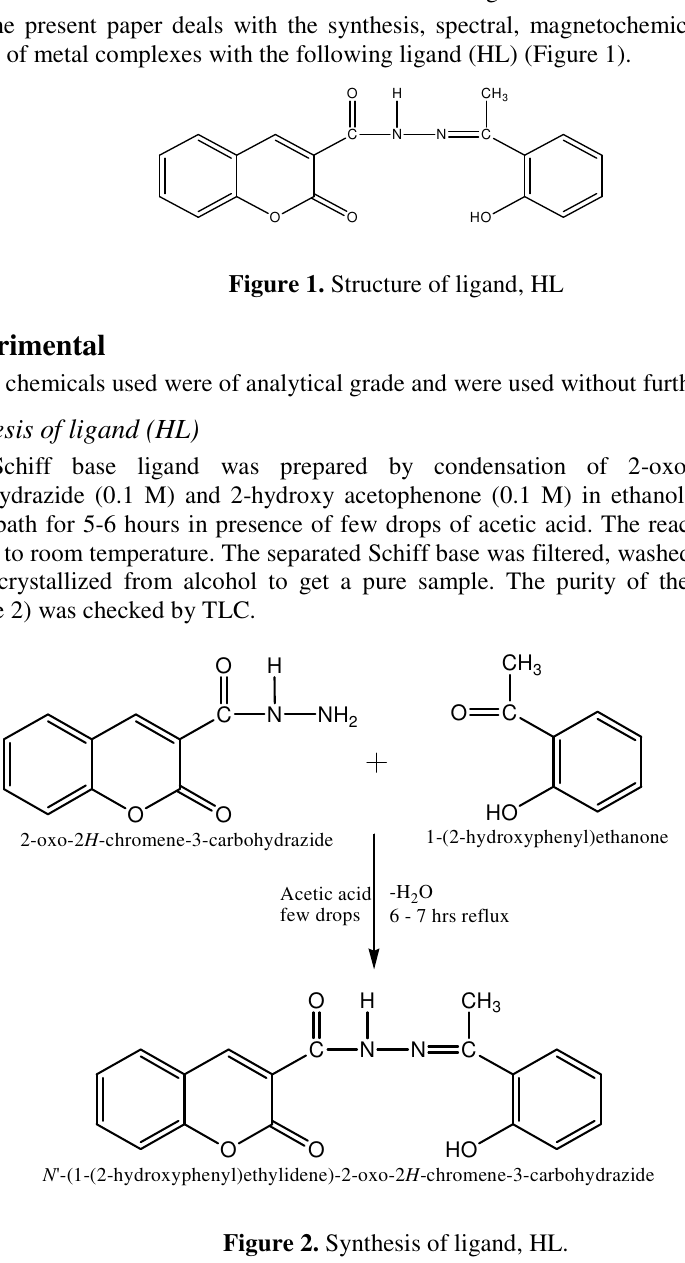
Figure 2. Synthesis of ligand,